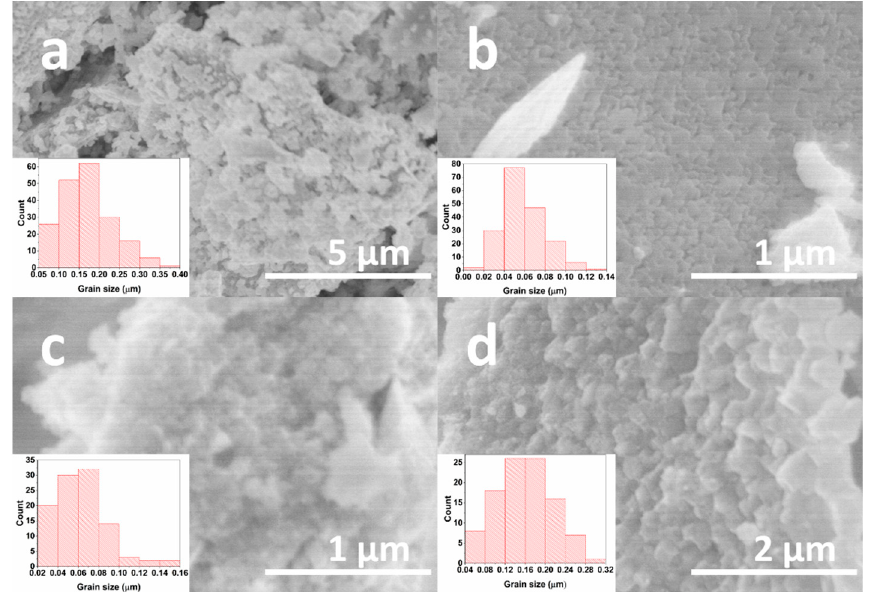
Figure 5. SEM images and grain size distribution of Bi 0.9 La 0.1 Fe 0.85 Mn 0.15 O 3 . ( a ), Bi 0.75 La 0.25 Fe 0.85 Mn 0.15 O 3 ( b ), Bi 0.5 La 0.5 Fe 0.85 Mn 0.15 O 3 ( c ) and Bi 0.1 La 0.9 Fe 0.85 Mn 0.15 O 3 ( d ) solid solutions.